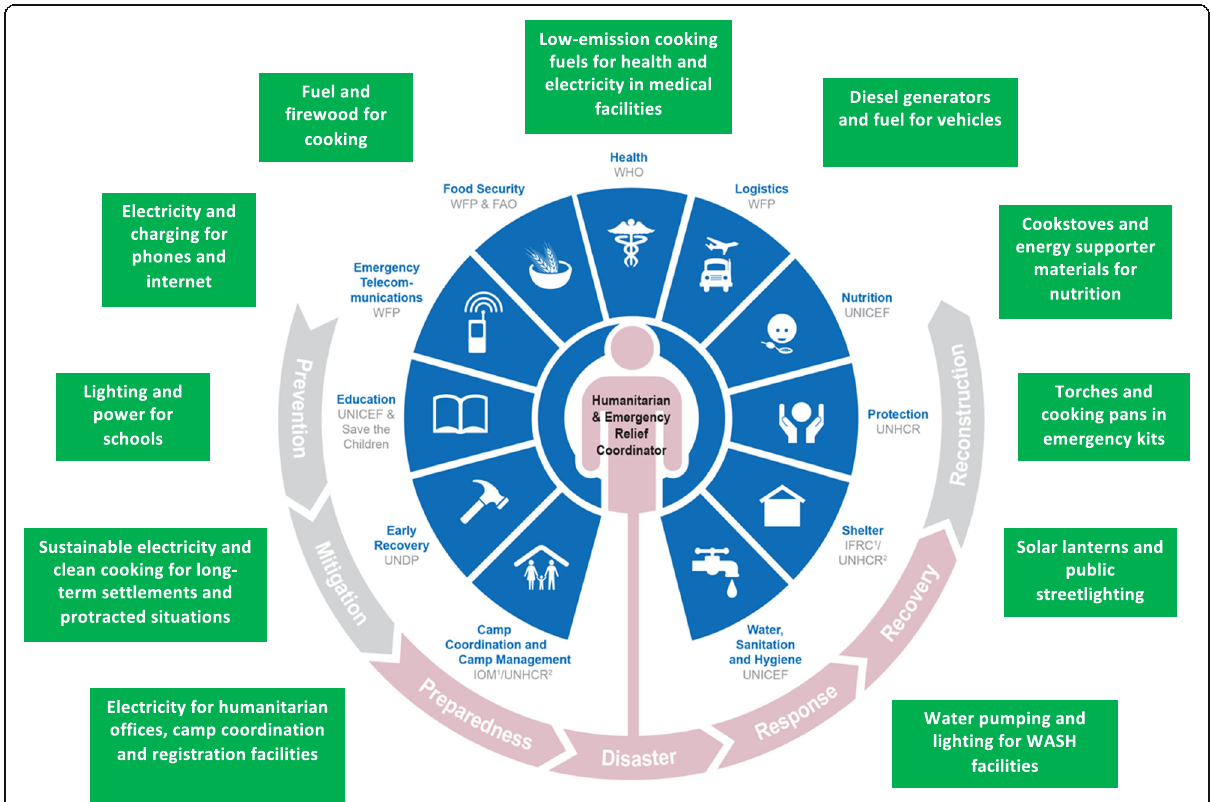
Fig. 1 The cluster system with examples of energy uses. Source: Adapted from (OCHA, 2020)